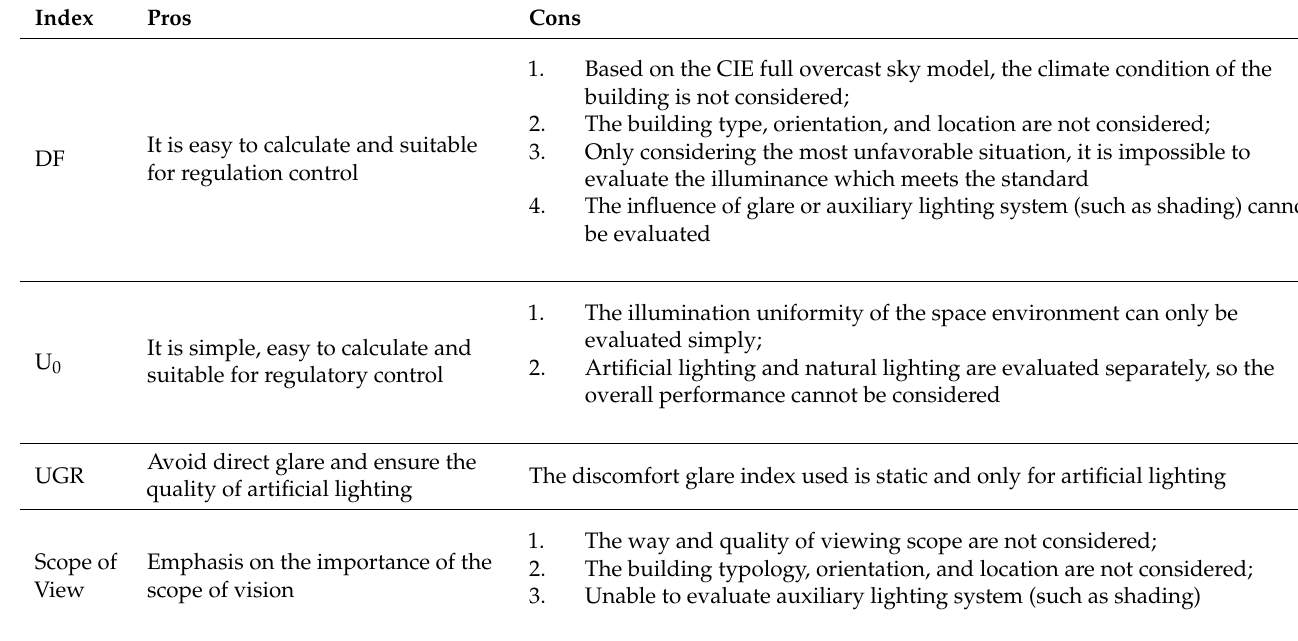
Table 1. Static lighting environment evaluation index.